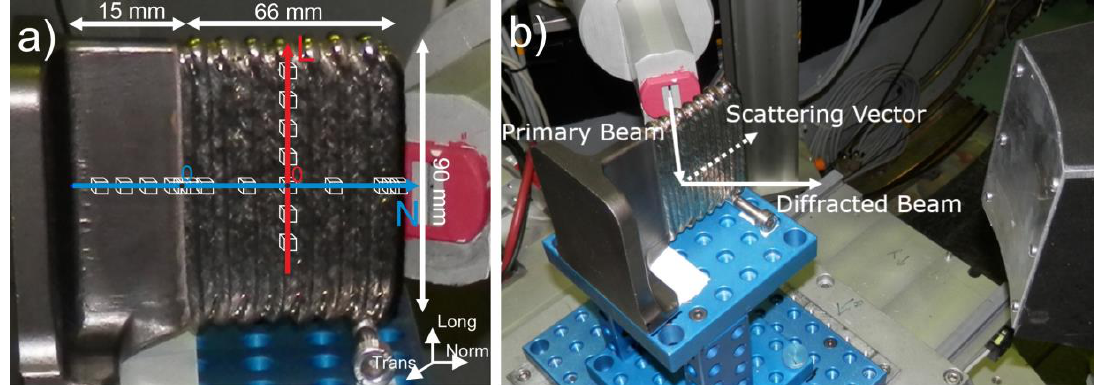
Figure 4. Photo of sample during neutron diffraction experiment on E3 with the schematics of ( a ) the measured points and the coordinate system, ( b ) the set-up. (Note that the sample is aligned for the measurement on the normal strain component).